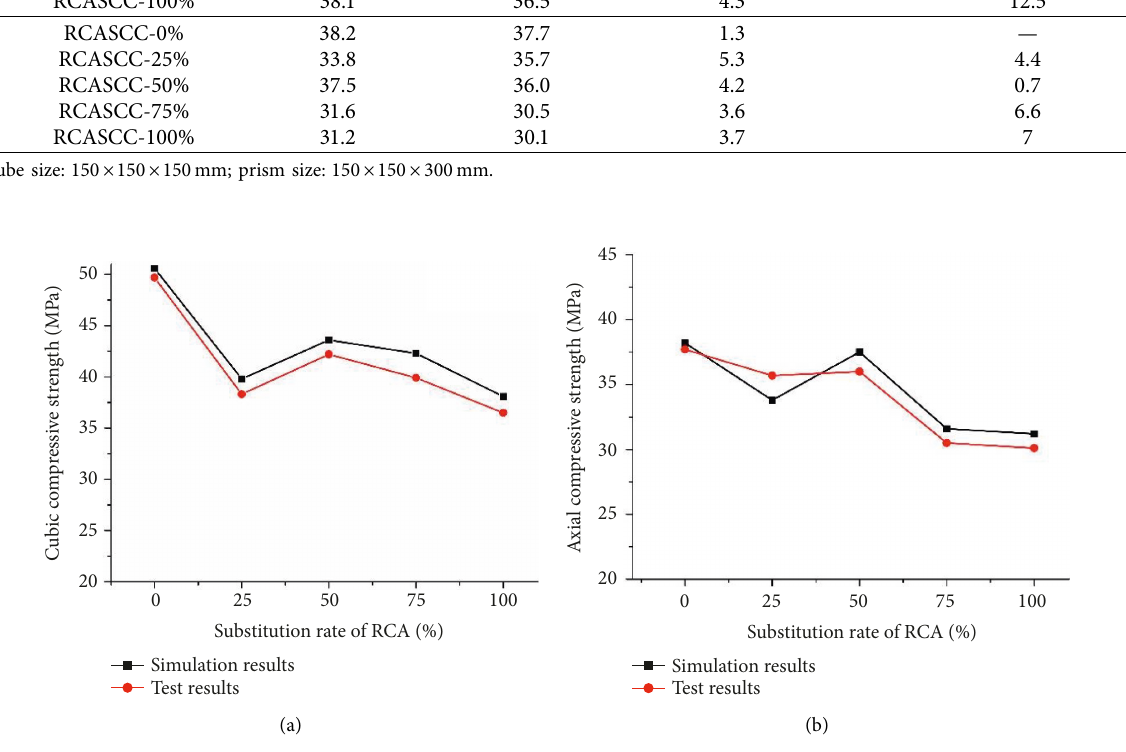
Figure 9: Substitution rate-compressive strength curve. (a) Substitution rate-cubic compressive strength curve. (b) Substitution rate-axial compressive strength